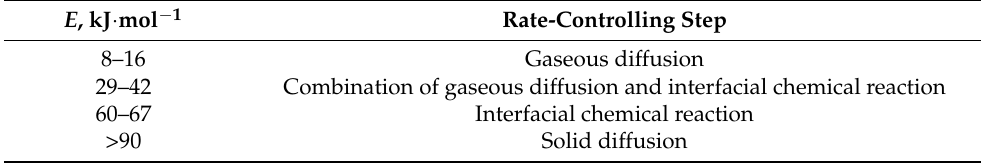
Table 4. Relationship between activation energy and reduction mechanism.